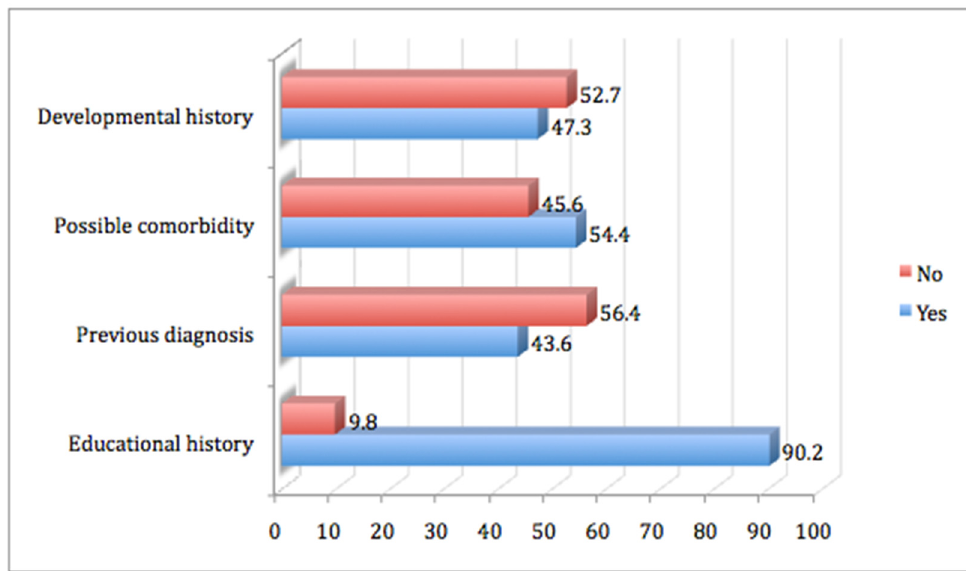
Figure 3. Clinical findings per diagnostic categories of the participants that were assessed at the